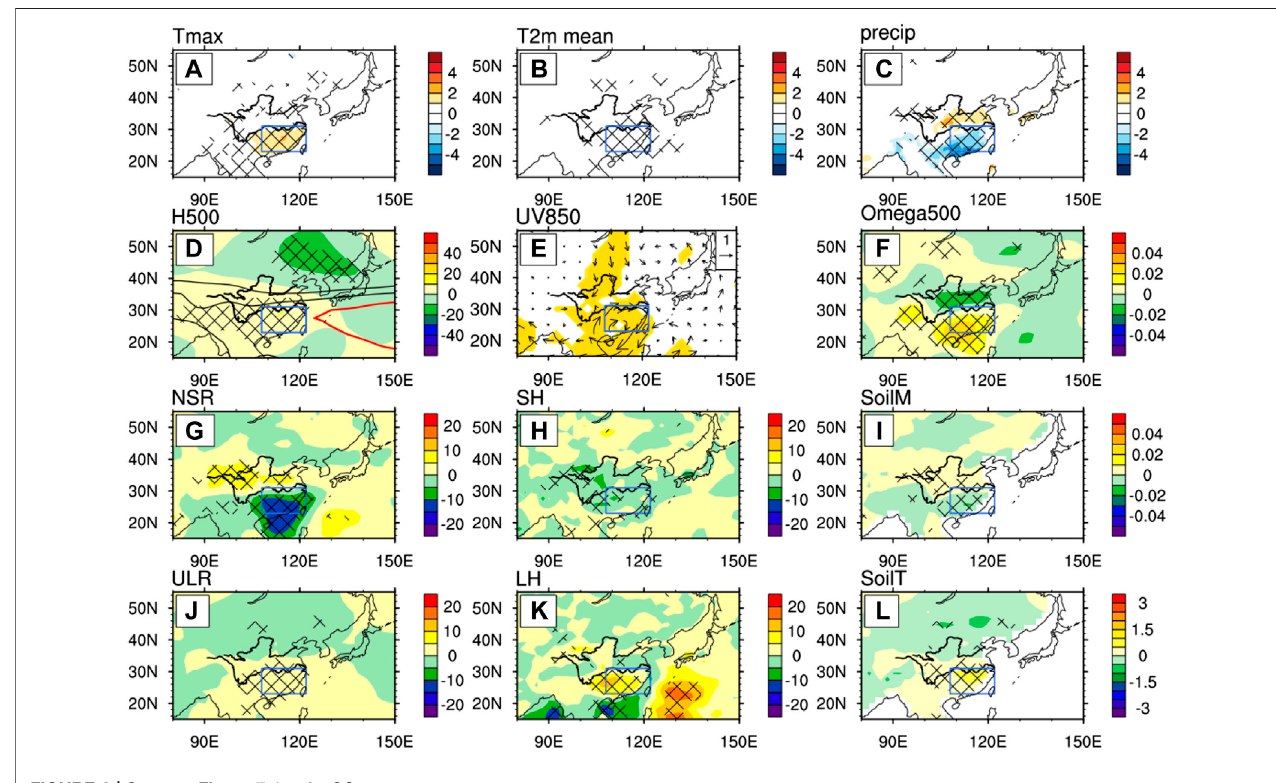
FIGURE 8 | Same as Figure 7 , but for SC.